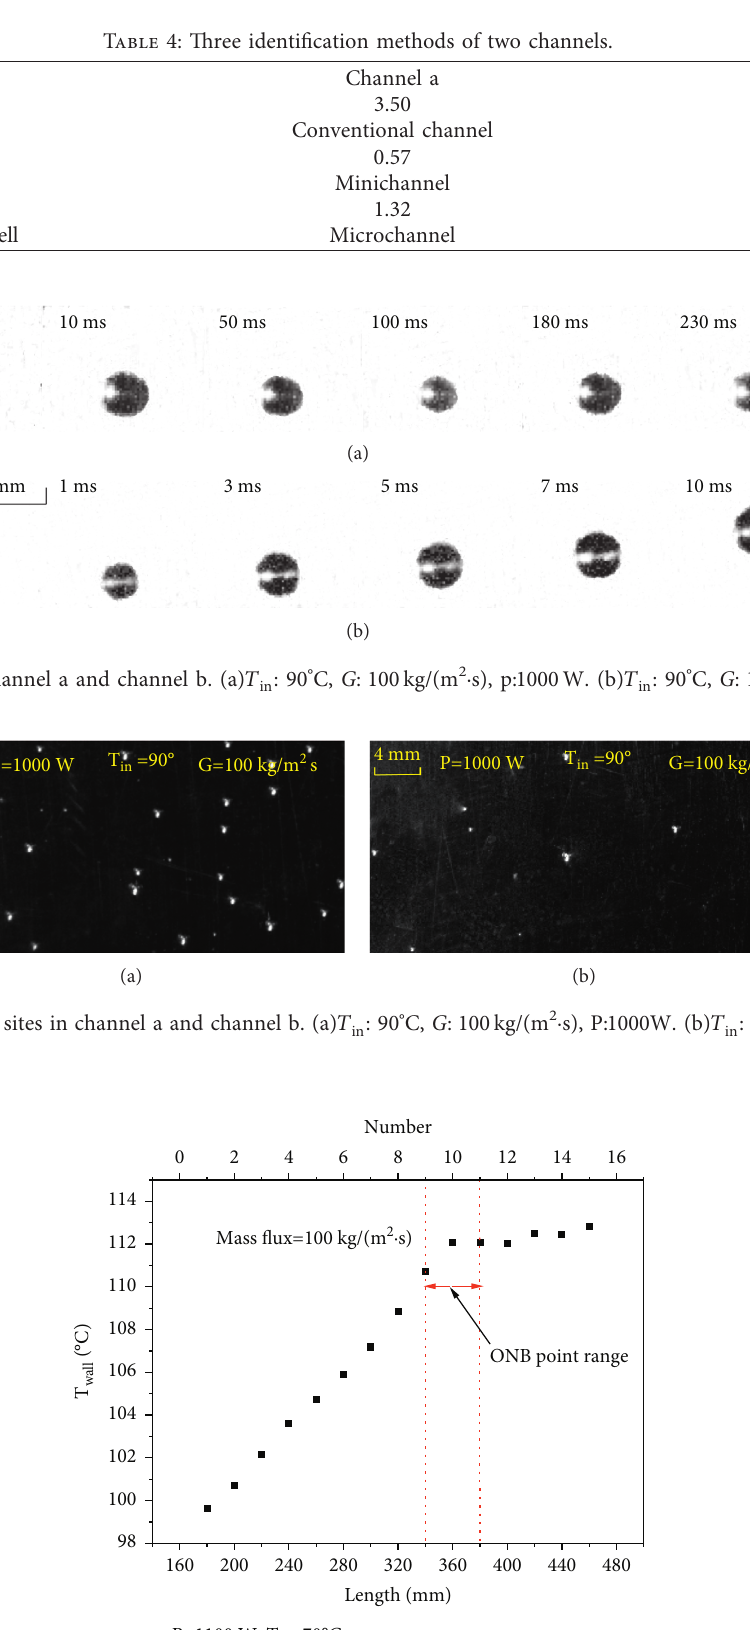
: 70 ° C, G : 100kg/(m 2 · in